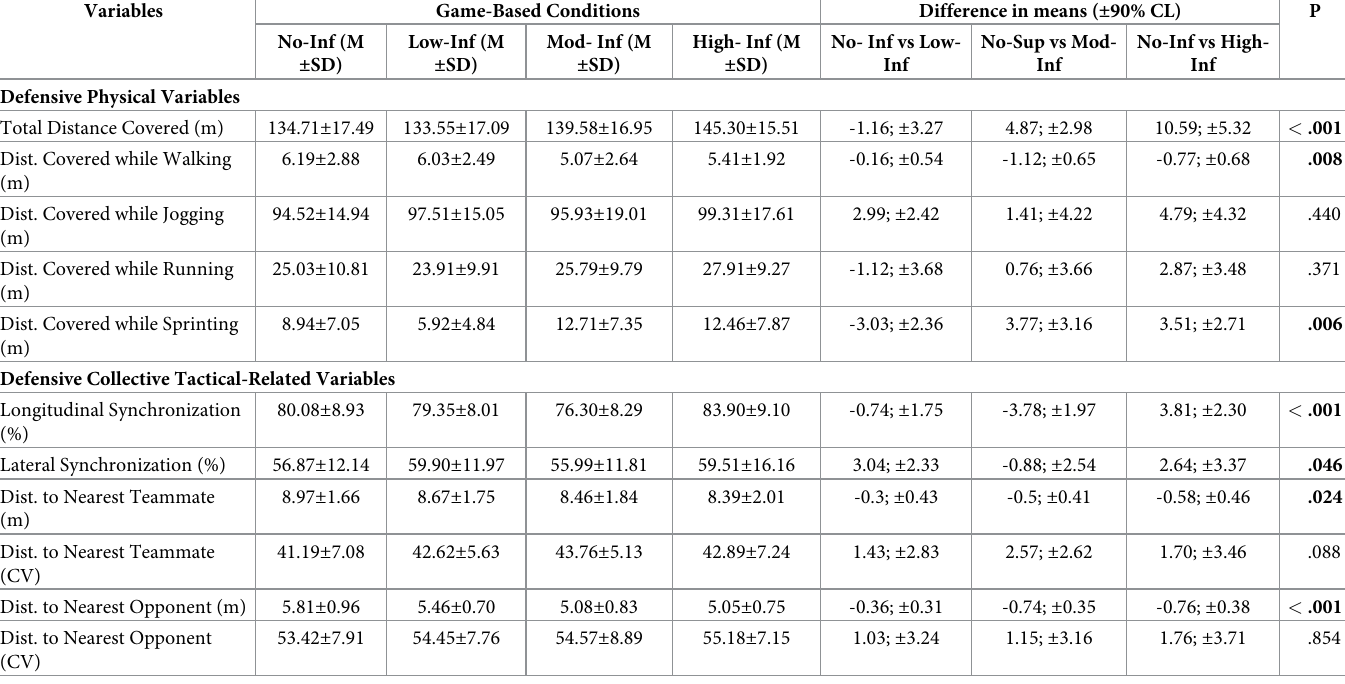
Table 4. Descriptive and statistical analysis for physical and collective tactical-related variables when playing in inferiority (opposition-perspective) during the defensive phase.